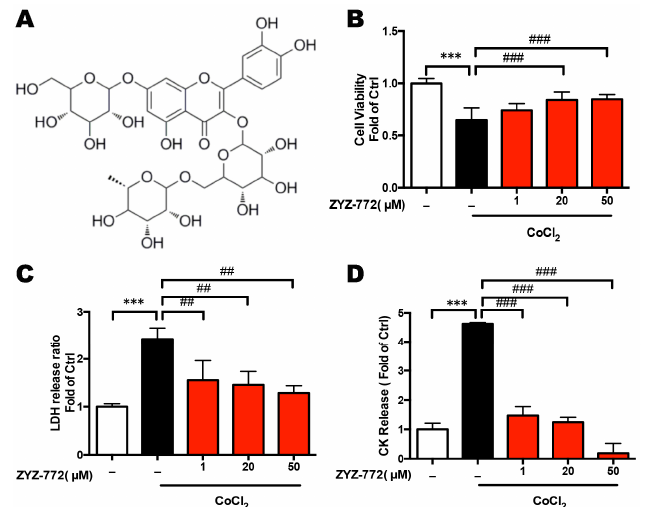
Figure 1. Analysis of the cardio-protective activities of ZYZ-772 in CoCl 2 -induced H9c2 cells. H9c2 cells were pretreated with/without different doses of ZYZ-772, followed by CoCl 2 (1 mM) stimulation for 12 h. ( A ) Chemical structure of ZYZ-772; ( B ) effects of different doses of ZYZ-772 on cell viability in CoCl 2 -induced H9c2 cells; ( C , D ): effects of ZYZ-772 on LDH leakage and CK release in CoCl 2 -induced H9c2 cells. *** p < 0.001 versus control group. ## p < 0.01; ### p < 0.001 versus the vehicle group. Error bars represent the data obtained from the experiments repeated three times or